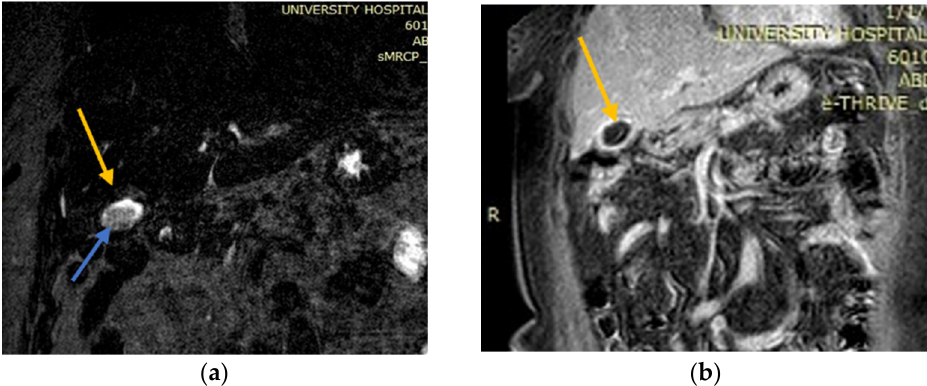
Figure 3. MRI images which showed findings consistent with acute cholecystitis. ( a ) Coronary MRI- image T1 post contrast of a gallbladder with diffuse mural thickening and contrast enhancement; ( b ) T2 MRI source image showing no perforation of the gallbladder. MRCP excluded choledocholithiasis and dilatation of the common bile duct. Yellow arrows: gallbladder; blue arrows: intraluminal stone and bile.